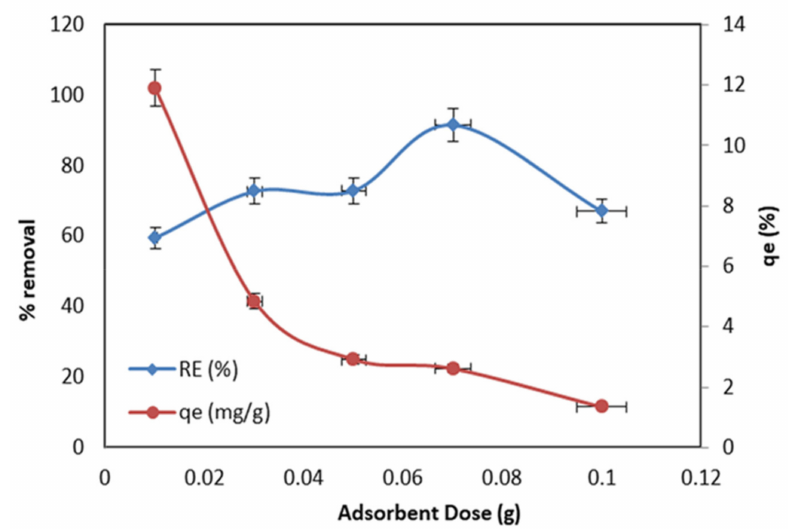
Figure 7. Effect of MnO 2 /PF biochar dosage on the removal of MO adsorption capacity and removal efficiency (pH 2.5; 10 mg/l, initial MO concentration; and 24 h, contact time)